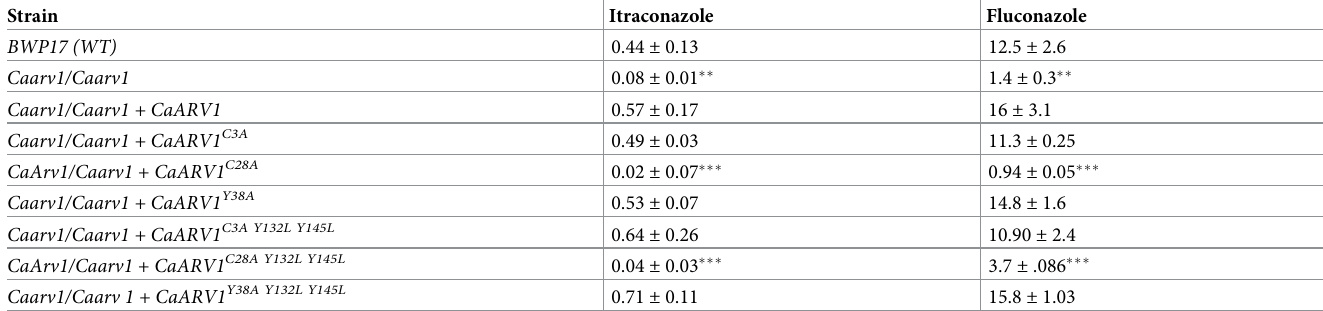
Table 2. Antifungal susceptibilities of Caarv1/Caarv1 mutant